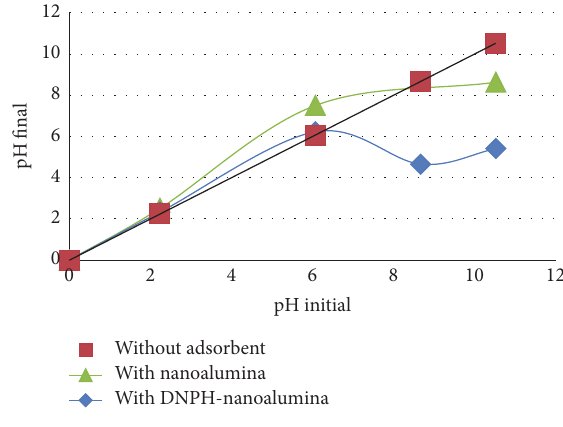
Figure 7: Determination of pH